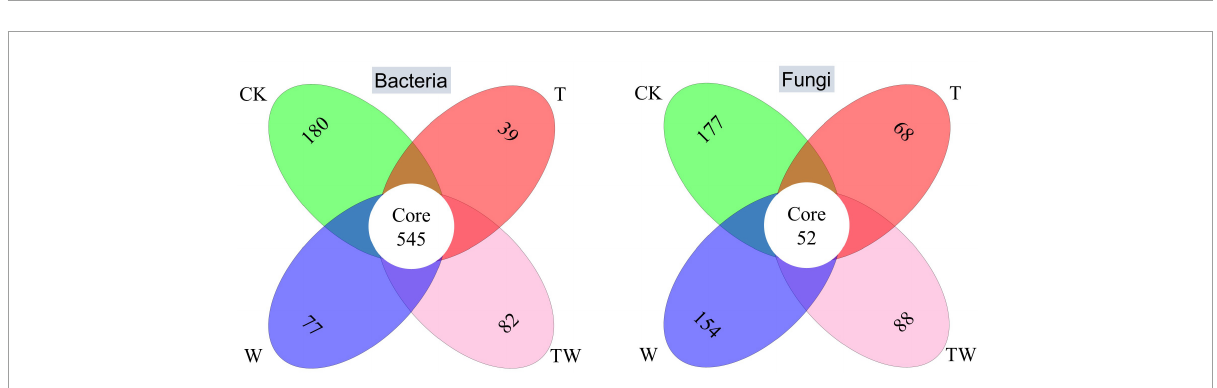
FIGURE4 Venn diagram of the soil bacterial (left) and fungal (right) OTU associated with different treatments. The numbers in different ovals represent the specific OTU in different treatments, and the number of the core represents the common OTU detected in all the treatments. CK, control; T, increasing temperature; W, increasing precipitation; TW, their